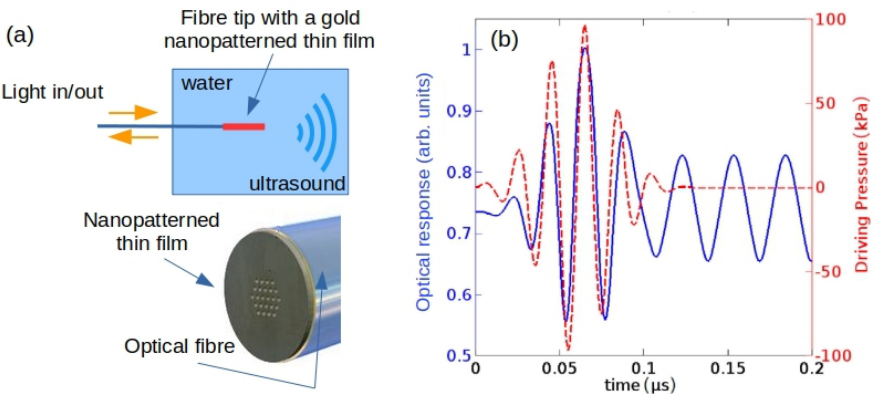
Figure 18. ( a ) Schematic diagram of a bubble-on-fibre system employing an optical fibre with the tip covered by a thin metal film patterned with nanoscale through holes. Such a film can be used (i) to generate a bubble by laser heating, (ii) to create conditions for extraordinary optical transmission (see the main text) and (iii) to host bubbles inside the holes. ( b ) Simulated optical response of a single water-filled hole in a metal film containing a bubble. The intensity of light interacting with the hole-bubble system becomes modulated due to bubble oscillations caused by an ultrasound pressure wave. Reproduced from [218]. Copyright 2017 by the American Physical